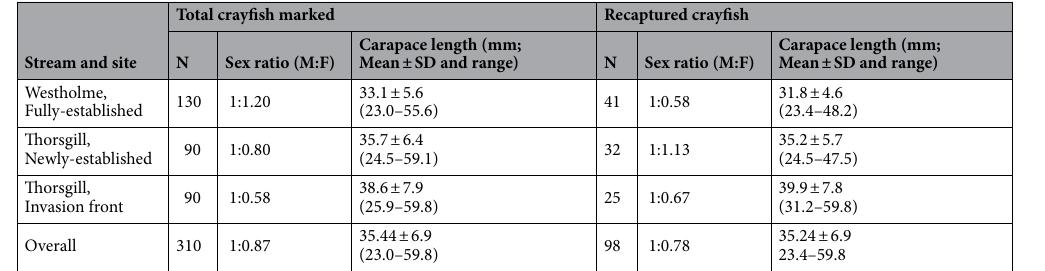
Table 2. Numbers of marked, and recaptured, signal crayfish, as well as sex ratios and summary statistics for carapace length.